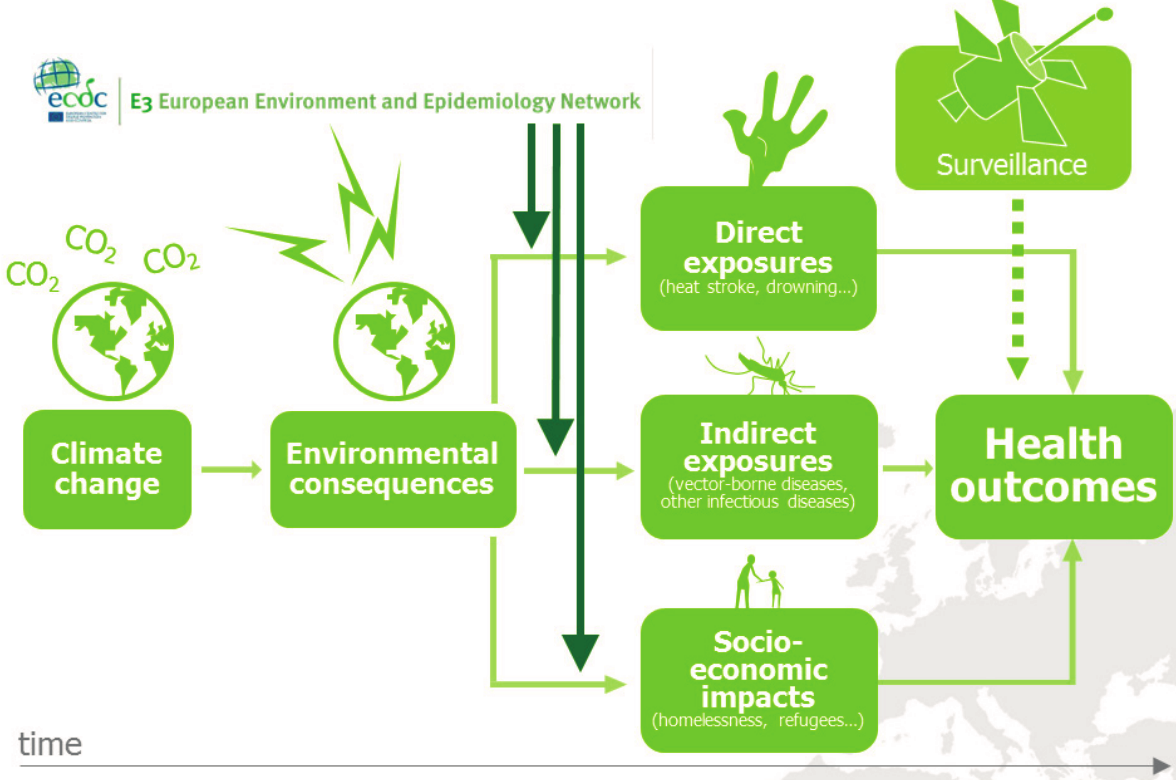
Figure 1. The European environment and epidemiology (E3)